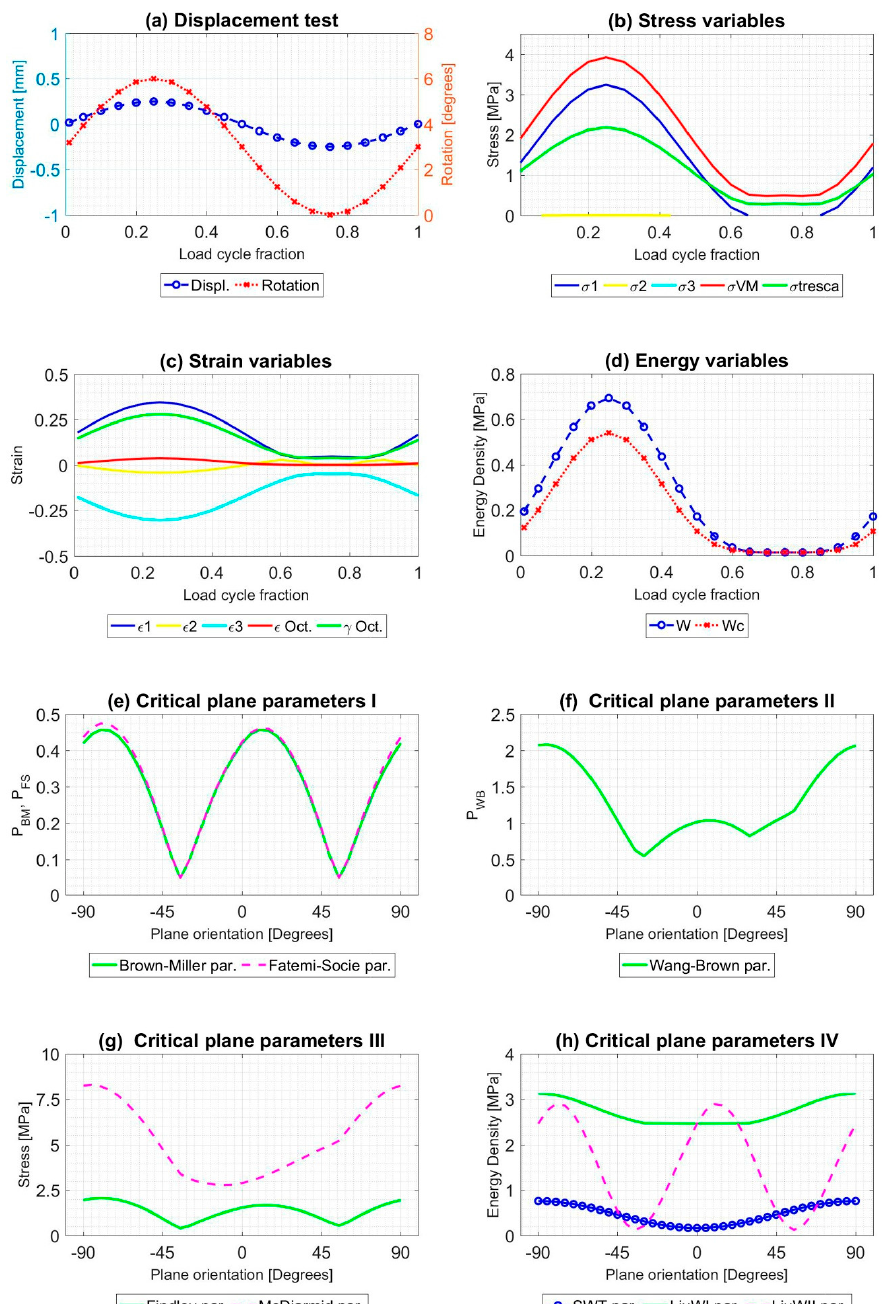
Figure 6. Result of the mechanical simulation of test B1 at the failure point of the sample caused by fatigue. Initial data from [45] fatigue. Initial data from